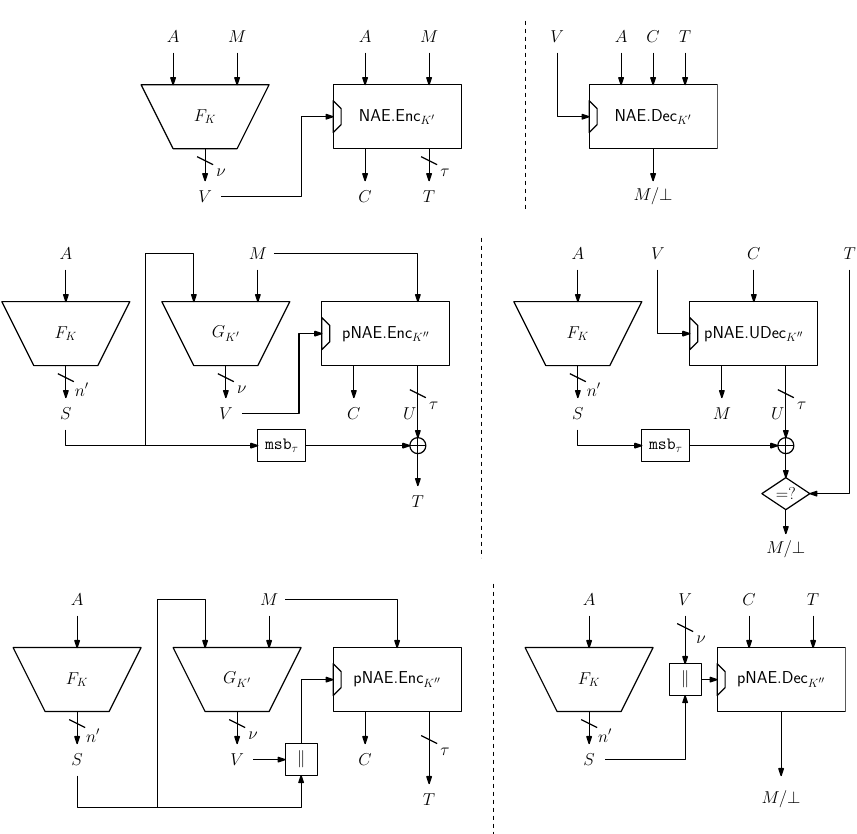
Figure 5: Schemes of DFV . (Top) a general scheme DFV1 , (Middle) a ciphertext translation- based DFV2 , and (Bottom) a nonce-stealing-based DFV3 . For each scheme, the encryption (decryption) routine is shown in the left